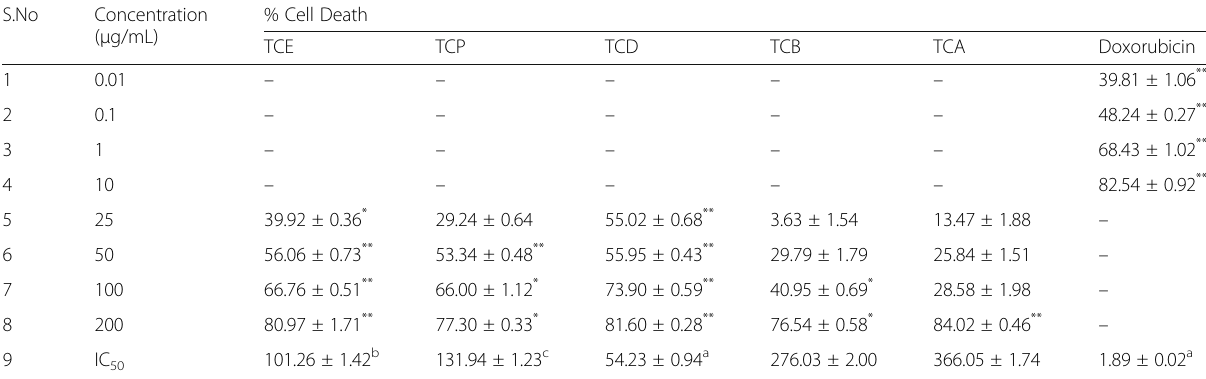
Table 3 Cytotoxicity results of T cordifolia on HeLa cell line. Cytotoxicity results of T cordifolia by MTT assay on HeLa (Human cervical carcinoma) S.No